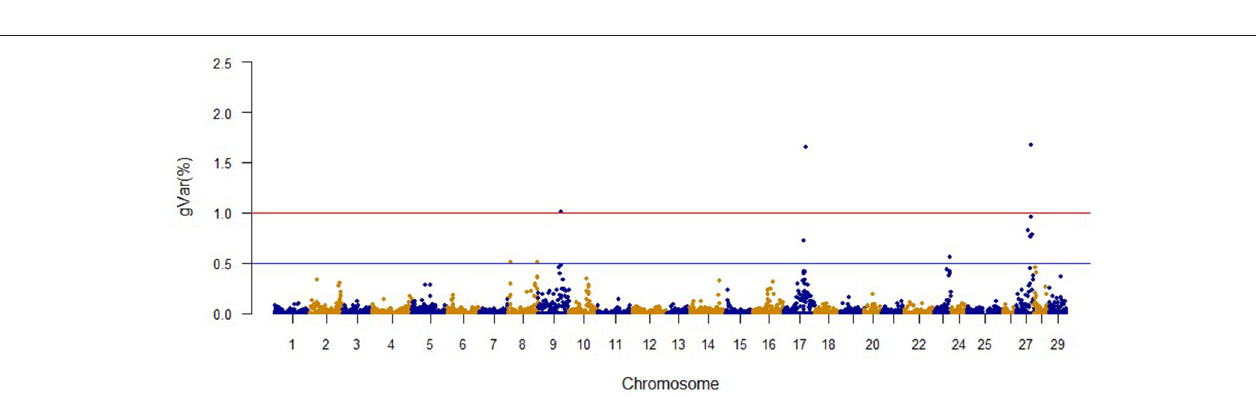
FIGURE 4 | The proportion of genetic variance explained by 20-SNP regions for 13-month body weight.